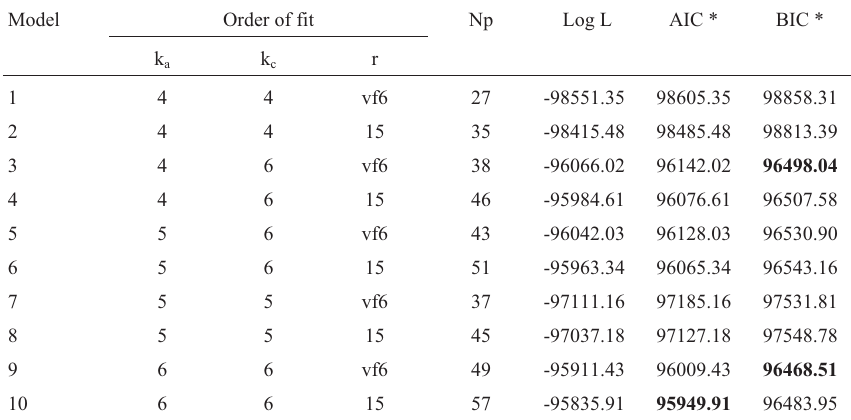
Table 2 - Order of fit for additive genetic (k a ) and permanent environmental (k c ) effects and residual structures (r), number of parameters (Np), log likeli- hood function (log L), Akaike’s information criterion (AIC) and Bayesian information criterion (BIC).